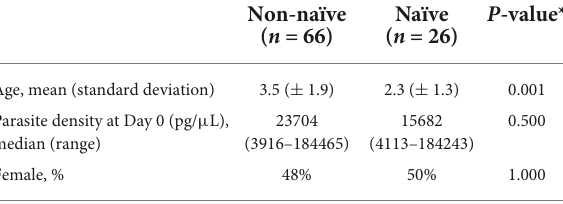
Non-naïve Naïve ( n = 66) ( n =